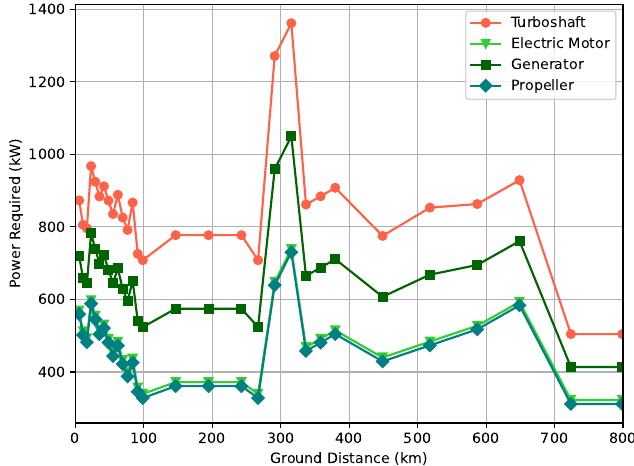
Figure 8. Power required to the turboelectric propulsive system.